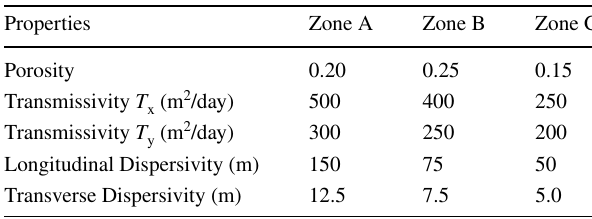
Table 1 Hydrogeological aquifer data (Sharif et al.